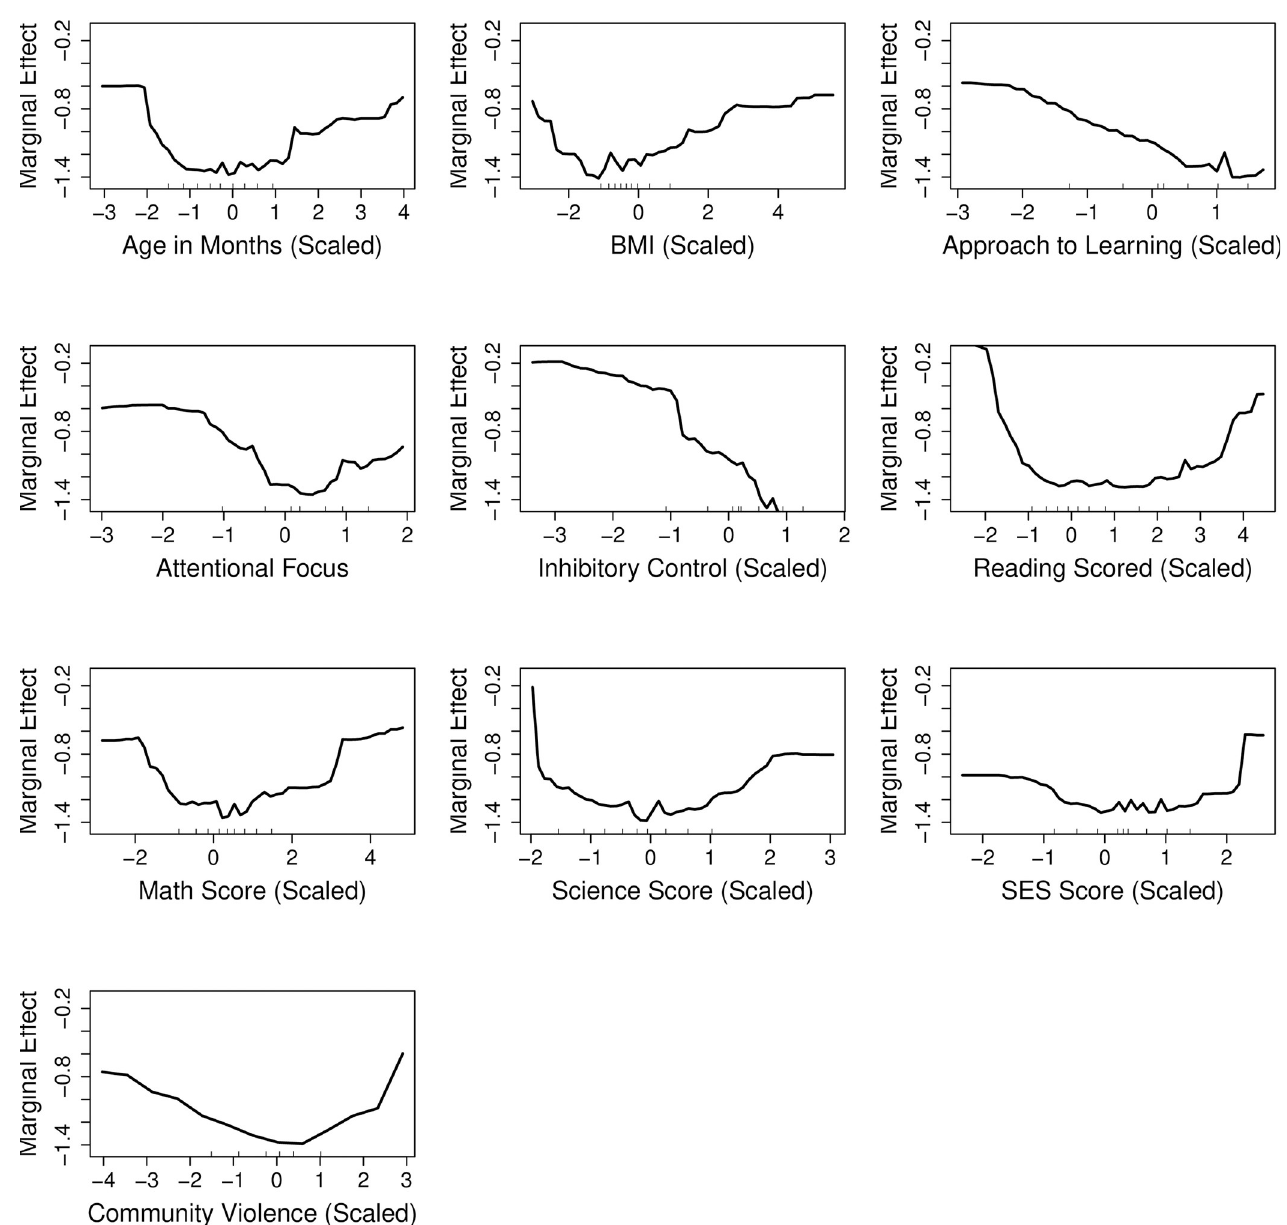
Fig 6. Partial dependence plots showing the dependence of the top ten important variables with prediction of externalizing problem behaviors. The y- axis represents the log odds of predicted probability for a fixed value of the variable of interest, conditional on all other variables (marginal effect). The x-axis represents the observed values of the variables scaled to have mean of zero and standard deviation of 1. BMI = body mass index, SES = socioeconomic status.